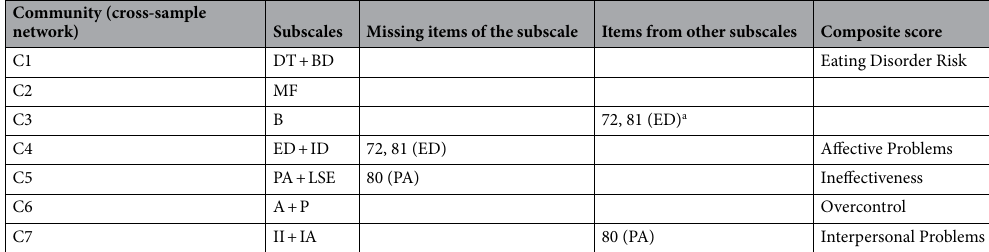
Table 2. Community composition of the median structure of the cross-sample network according to the Spinglass algorithm. The last column reports the composite score of the EDI-3 questionnaire corresponding to the detected community. a Plus item 71. According to the EDI-3 manual, this item is not classified into any subscale and is not even taken into account during the scoring